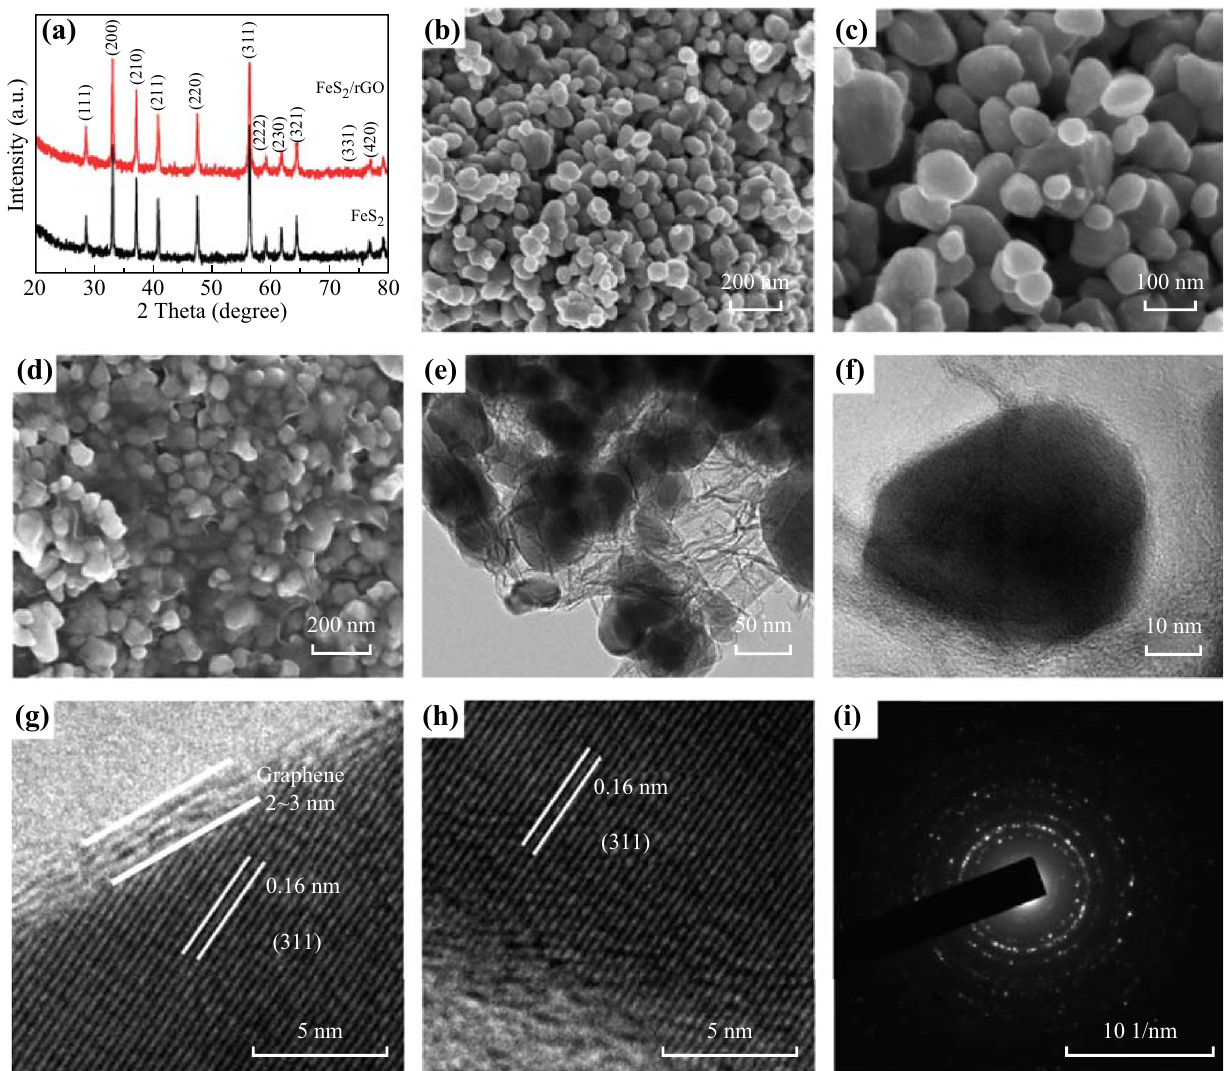
Fig. 2 a XRD patterns of the as-prepared FeS 2 and FeS 2 /rGO composite, b , c SEM images of FeS 2 , d SEM image, e , f TEM images, g , h HRTEM images, and i SAED pattern of FeS 2 /rGO composite